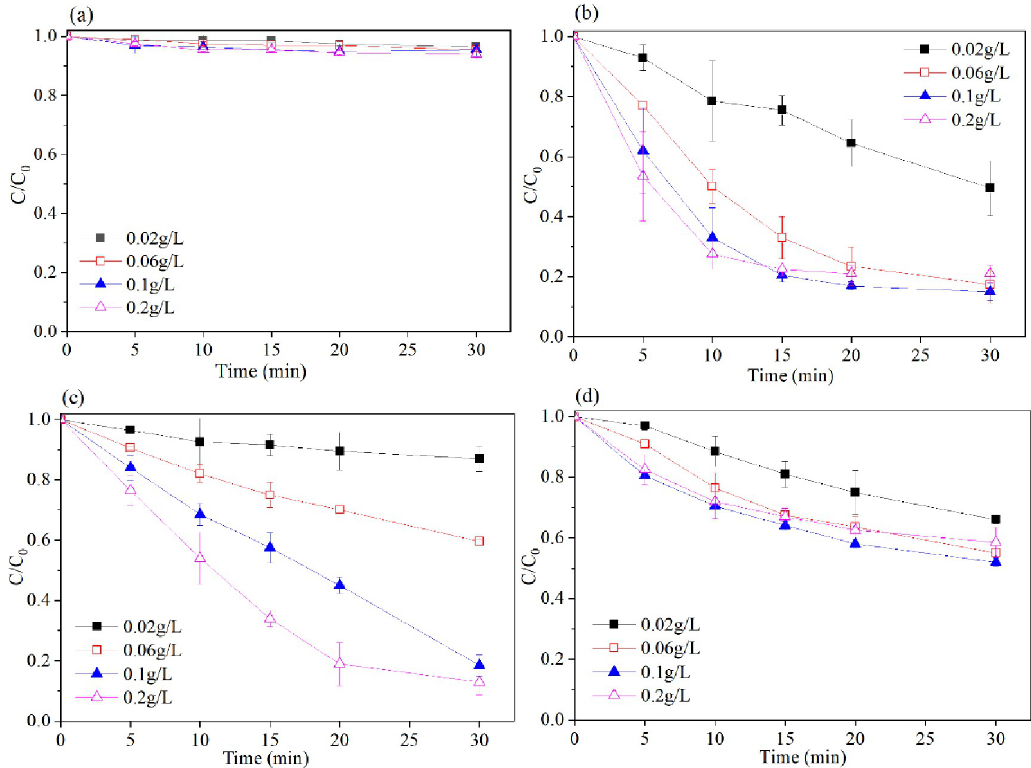
Fig 2. Effect of iron loading on the degradation of 2,4,6-TCP in four systems. (a) Fe 0 ; (b) Fe 0 /H 2 O 2 ; (c) Fe 0 /PMS; (d) Fe 0 /PS. Conditions: c(2,4,6-TCP) = 0.2 mmol•L -1 ; c(Ox) = 1 mmol•L -1 ; pH = 3.2 ± 0.05.